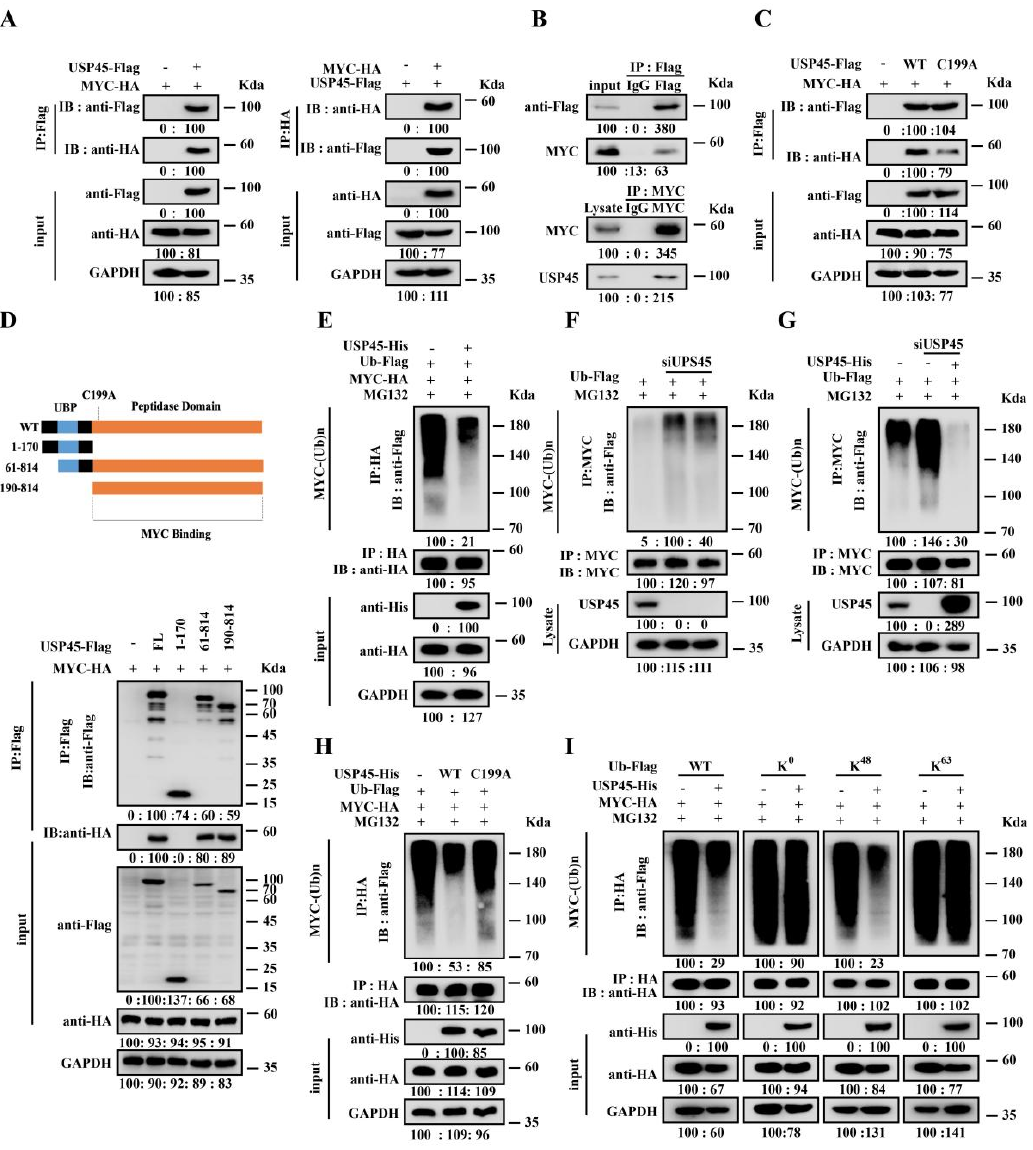
Figure 2. USP45 interacts with and deubiquitinates MYC. ( A , B ) USP45 interacts with MYC: ( A ) Co-IP of ectopic USP45 and MYC: HEK293T cells transfected with USP45-Flag and MYC-HA were assayed by co-IP with anti-Flag (left) or anti-HA (right), plvx-puro vector as the negative control; ( B ) Co-IP of ectopic USP45 and endogenous MYC, or endogenous USP45 and endogenous MYC, HEK293T cell lysates were assayed by co-IP with anti-Flag and control IgG (up) or anti-MYC and IgG (down). ( C ) USP45 interaction with MYC was independent from its catalytic activity: HEK293T